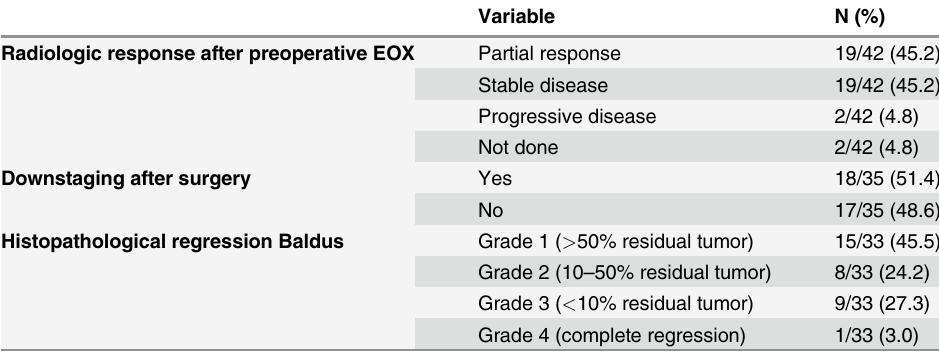
Table 3. Response rates to preoperative EOX chemotherapy.